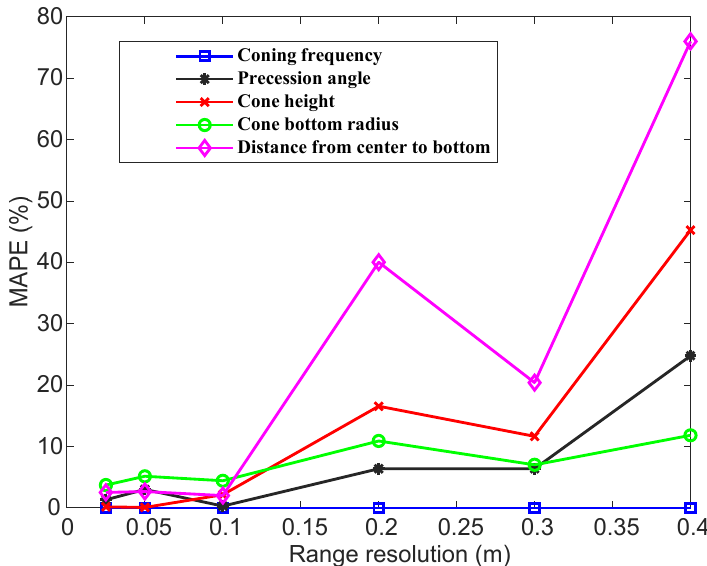
Figure 19. MAPE of five parameters with different range resolutions.